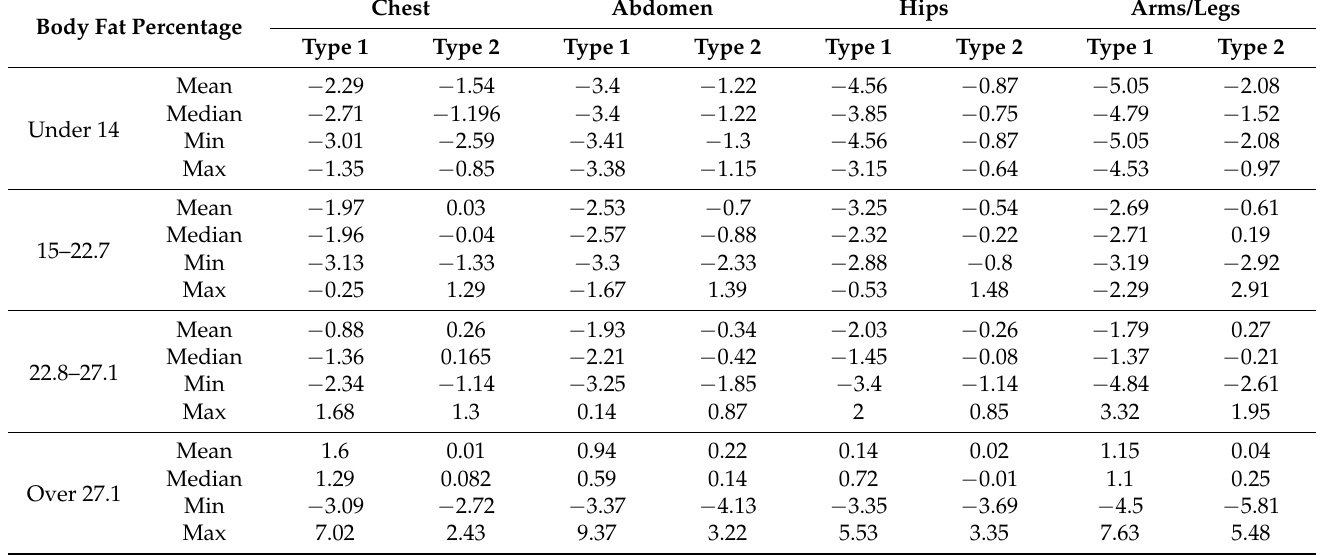
Table 7. Results for